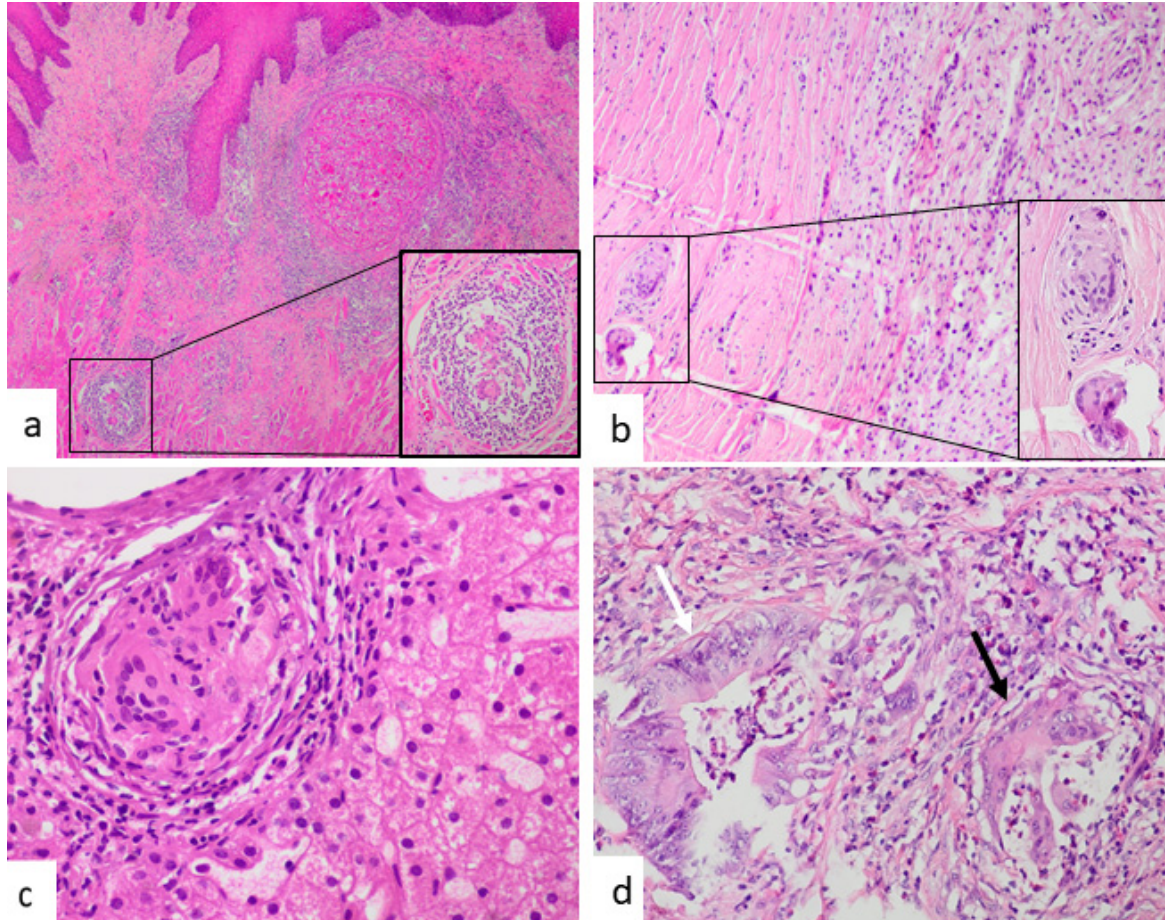
Figure 4. ( a ) Peritumoral granulomas in a squamous cell carcinoma of the tongue. Granulomas are peritumoral and have no relationship with keratin material (case 6) (HE, ×40). The inset highlights the absence of foreign body component and non-necrotizing morphology. ( b ) Peritumoral granuloma in a case of cutaneous neurofibroma (case 8) (HE, ×100, inset ×400). ( c ) Hepatic granuloma in a peritumoral location. The granuloma is surrounded by hepatocytes without visible neoplastic cells (case 7) (HE, ×600). ( d ) Intratumoral granuloma in a case of rectal adenocarcinoma. The granuloma (black arrow) is in close relationship with malignant glands present at the left (white arrow) (case 9) (HE, ×400).